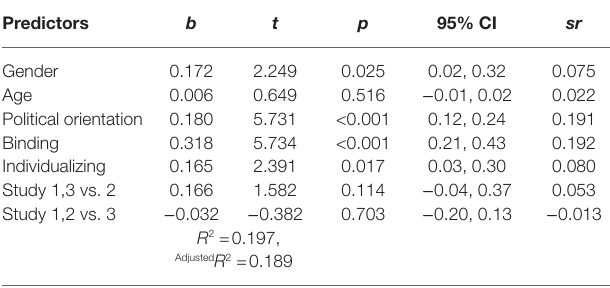
TABLE 9 | Predictive effects of the broad moral foundations and covariates on desired tightness, all studies. Predictors b